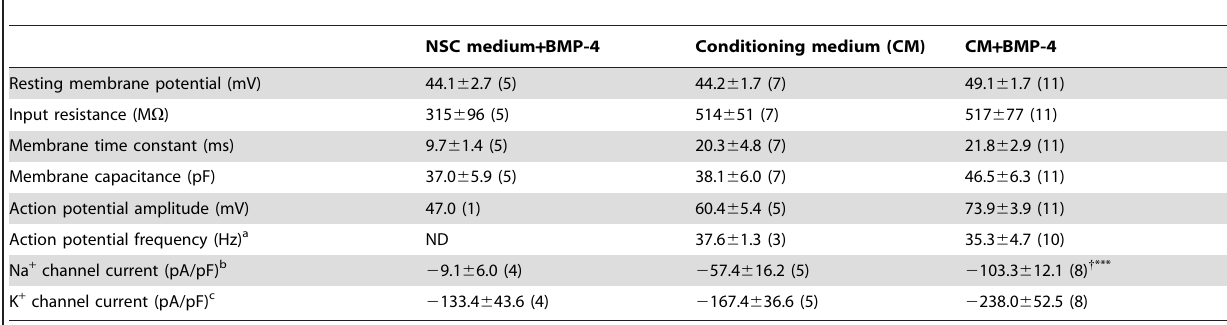
Table 1. Electrophysiological properties of differentiating neurons.